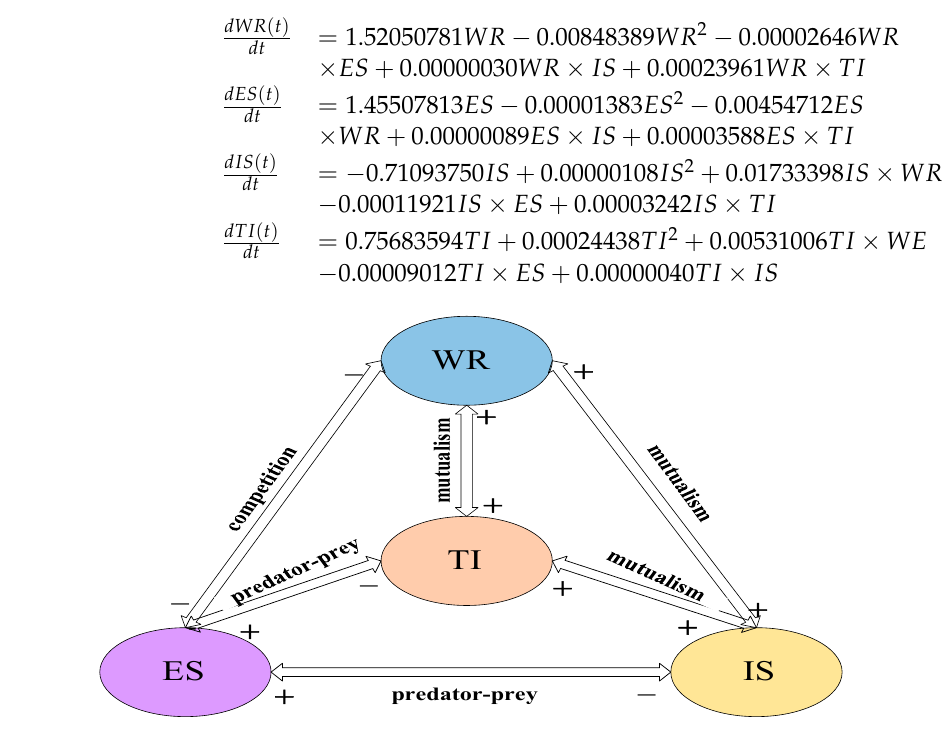
Figure 6. The relationship between Water Resources System-Economy System-Industrial System- Technology Innovation System in Hebei.